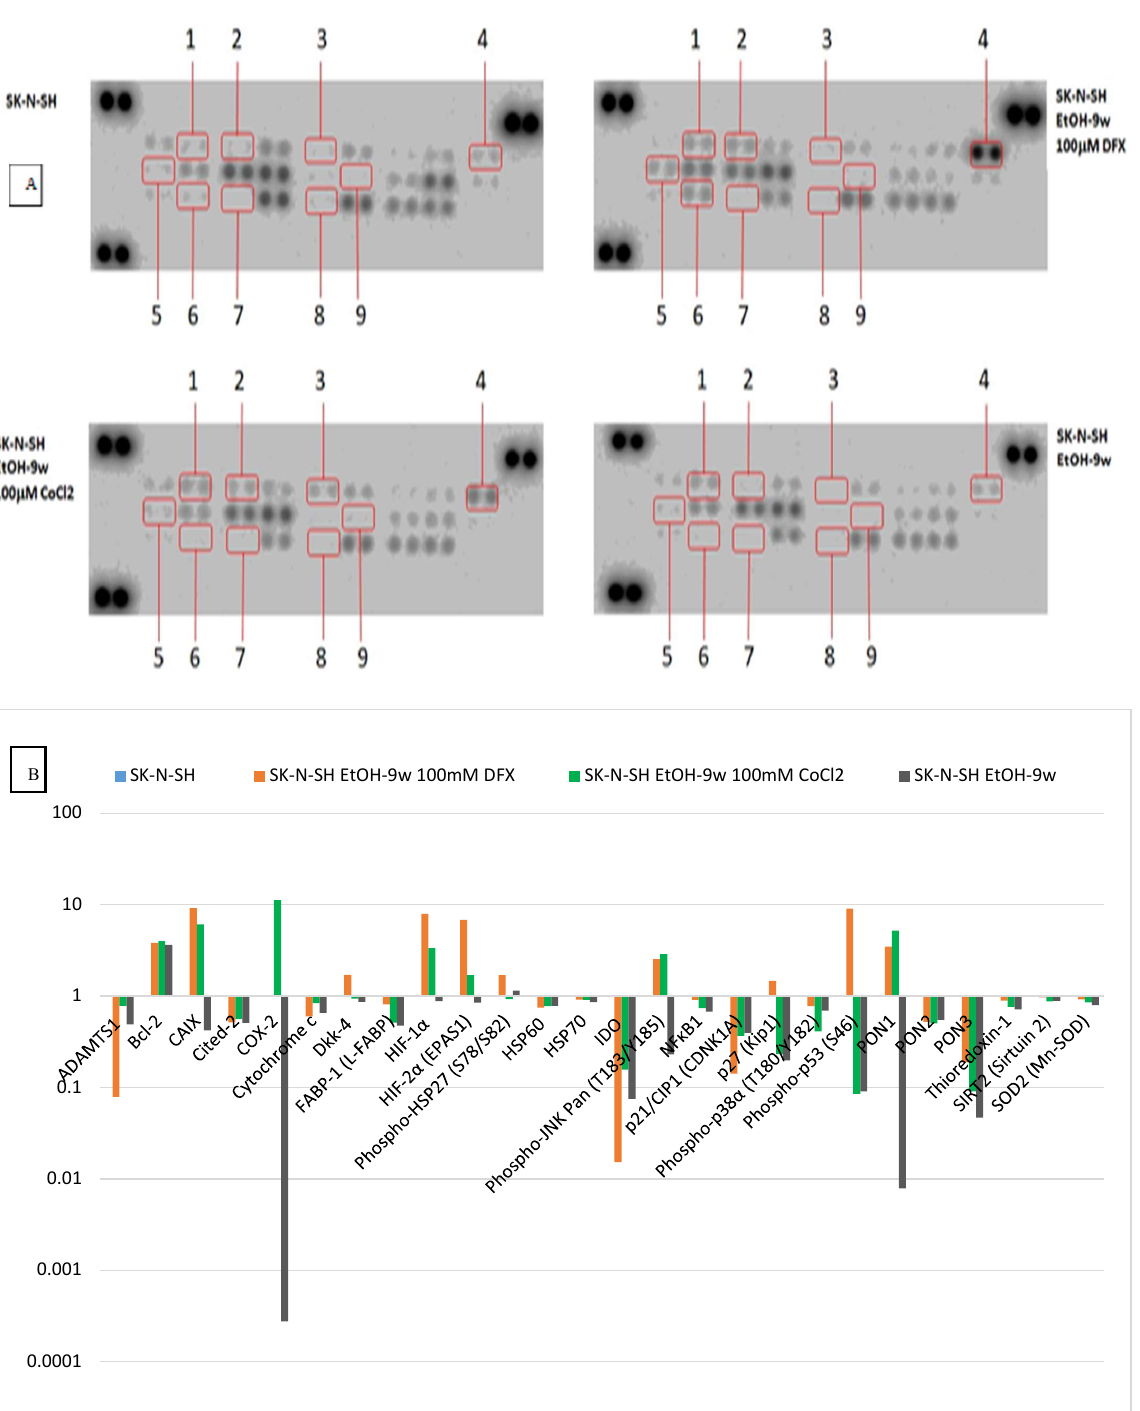
Figure 8. The effects of hypoxic treatment on stress-related proteins in long-term ethanol-exposed SK-N-SH cells. The total protein lysates (100 µ g) were subjected to the proteome profiler stress array analysis. ( A ) Dot-blot image: 1. Bcl-2; 2. Carbonic Anhydrase IX (CA9); 3. COX-2; 4. HIF-1 α ; 5. HIF-2 α (EPAS1); 6. Phospho-p53 (S46); 7. PON1; 8. PON3; 9. Phospho-JNK Pan